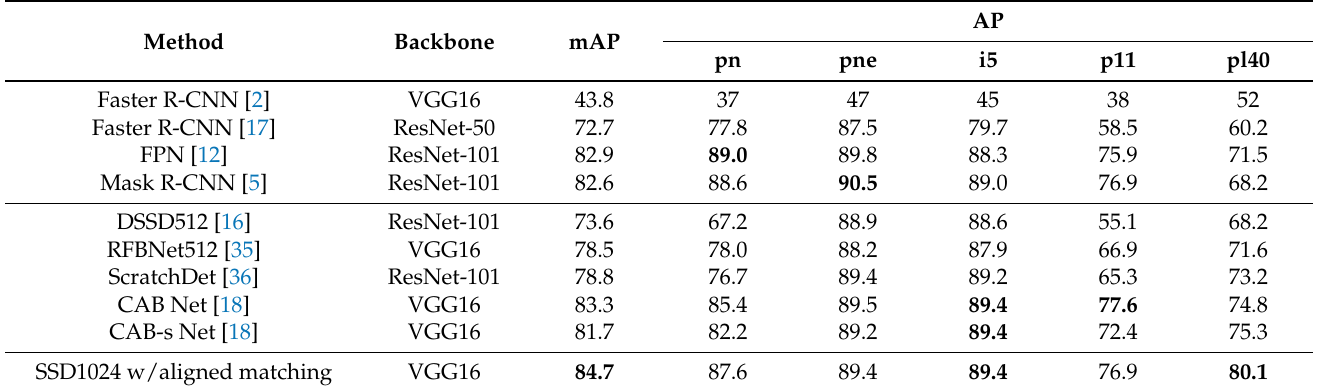
Table 8. Comparison of aligned matching with state-of-the-art